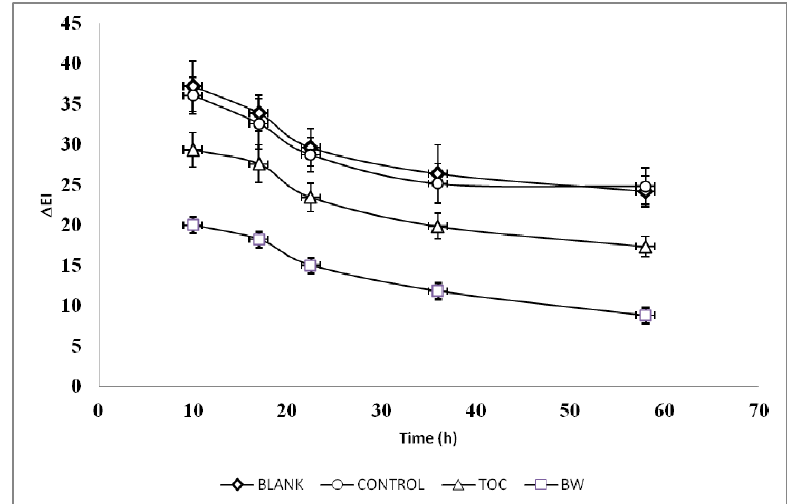
Figure 1. Typical trend of erythema index variations ( Δ EI) versus time for one subject. Formulations containing 2% of the active ingredients under study (blanch water extract, BW, or tocopheryl acetate, TOC) or containing no active ingredient (blank) were applied to the skin after UV-B exposure. No treated skin sites were used as